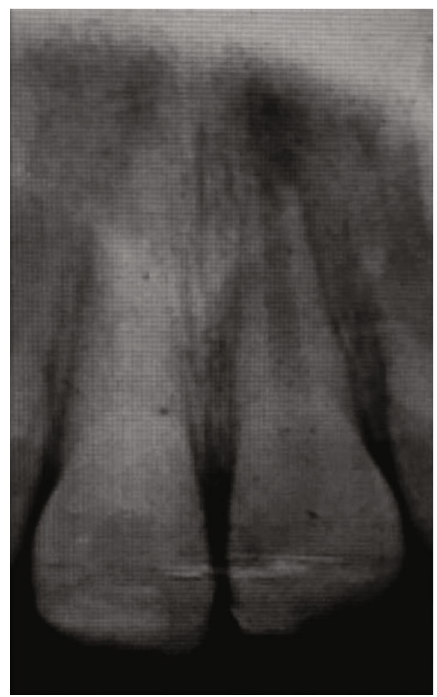
Figure 3: 6-month follow-up radiograph: a radiolucent periapical lesion adjacent to 21. The negative response to the cold test con fi rms pulp